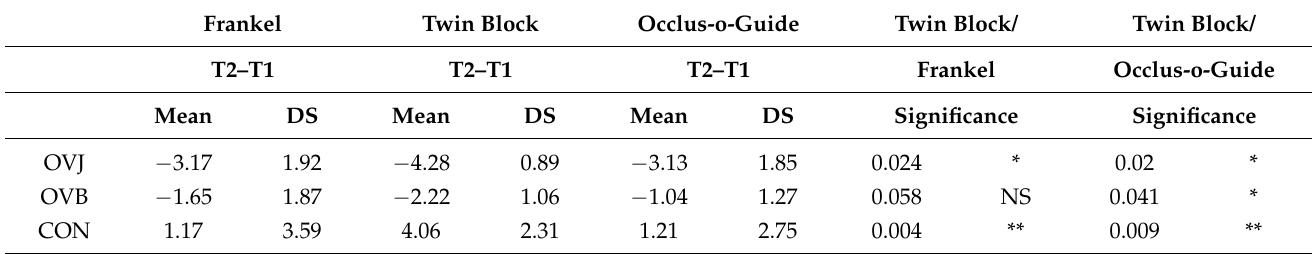
Table 8. Significant values between three treated